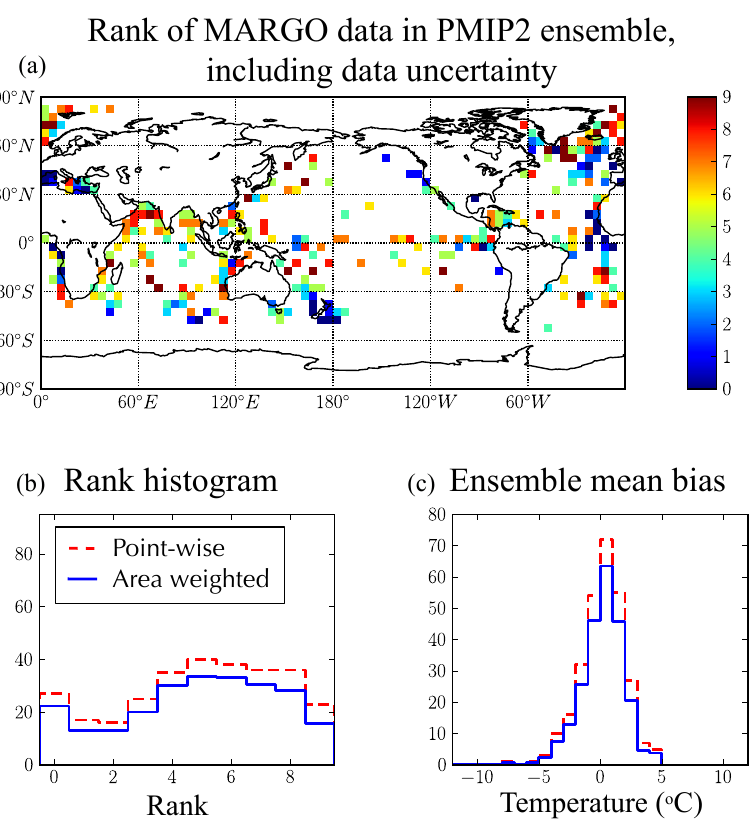
Fig. 7. (a) The rank of the MARGO data in the PMIP2 SST for the whole globe. (b) Area-weighted rank histogram of the ranks in plot (a) . High rank (red on the colour scale) indicates that MARGO is warmer at the LGM than the ensemble. (c) The histogram of the difference between the PMIP2 SST ensemble mean and the MARGO data for each data point in plot (a) . Both area-weighted and point-wise rank histograms are shown. The uncertainties in the MARGO data is taken into